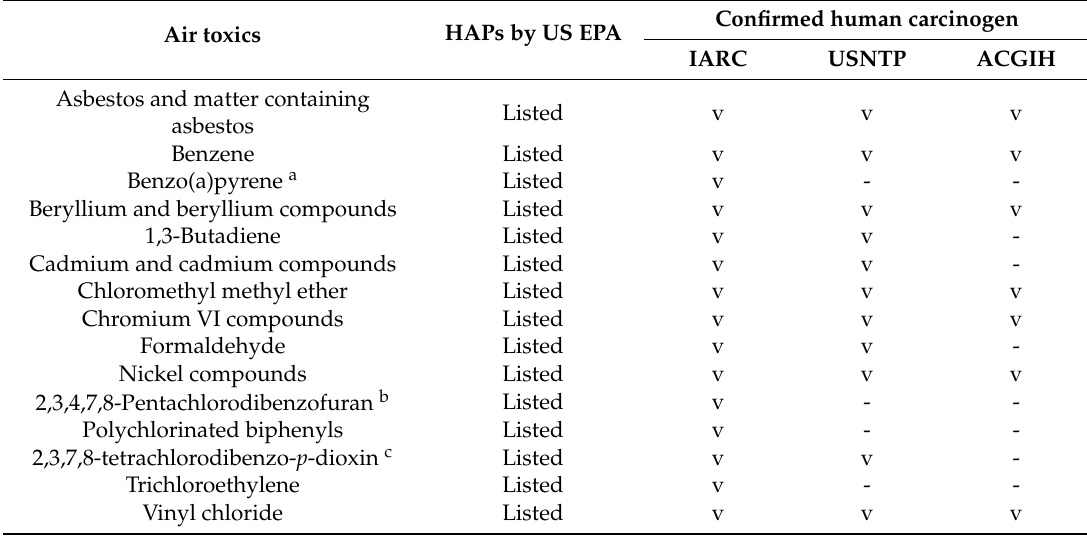
Table 1. The classification of human carcinogens for the air toxics designated in